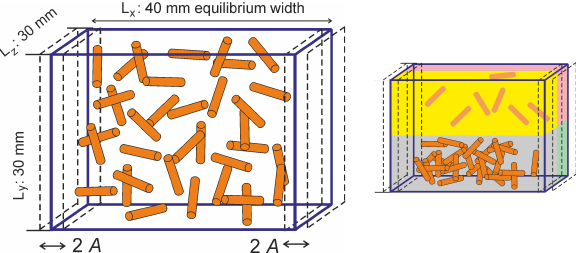
Figure 1. Left: Sketch of the setup for the simulations. It is simi- lar to the VIP-GRAN instrument described in Ref. [8]). The side walls can be vibrated to excite the particle ensemble mechani- cally in microgravity. Right: Sketch of the quadrants introduced in Sec. 3.1, with one cluster in the grey